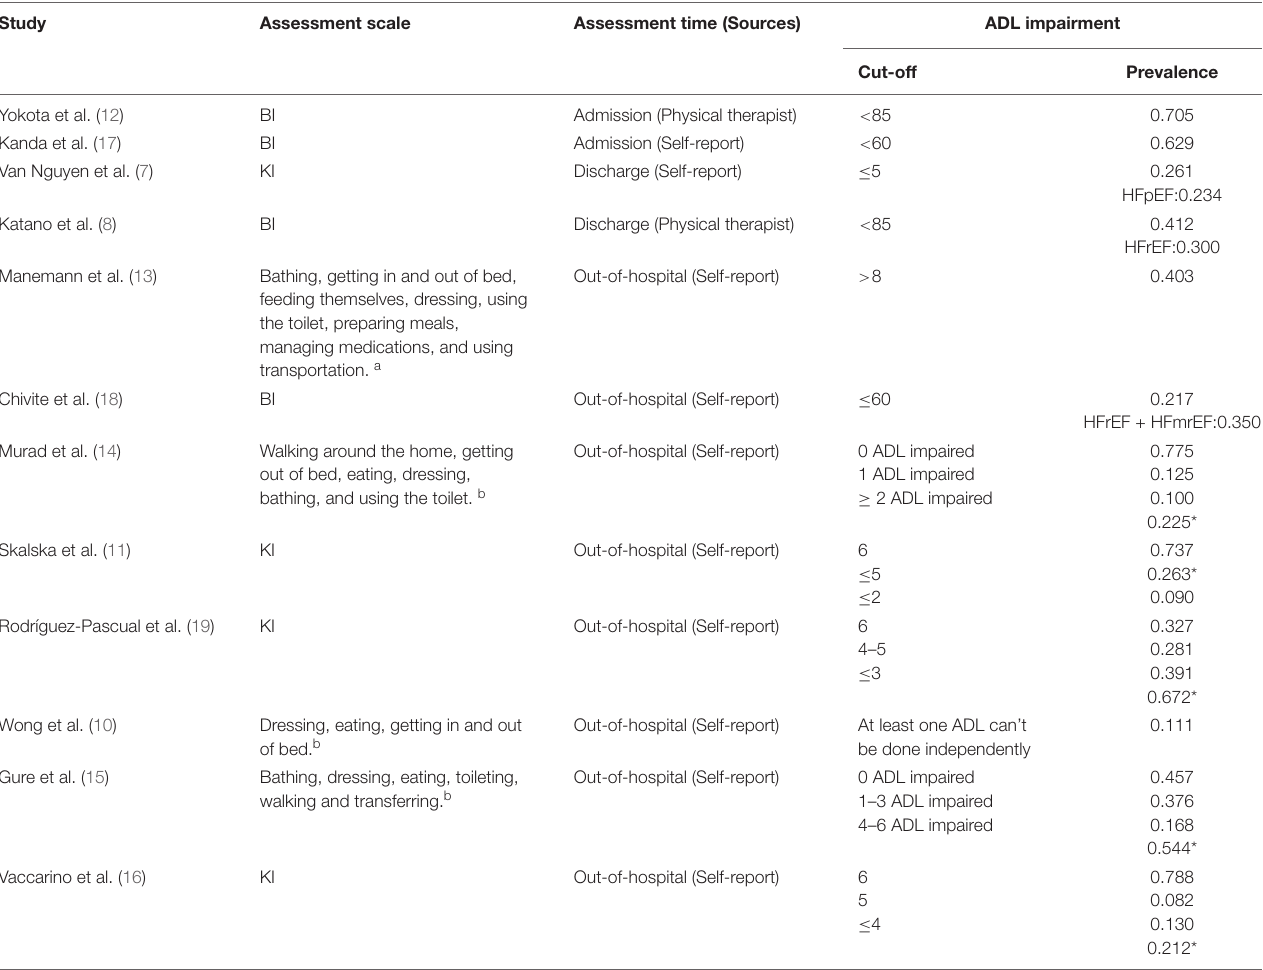
TABLE 1B | ADL-related characteristics of the 12 included